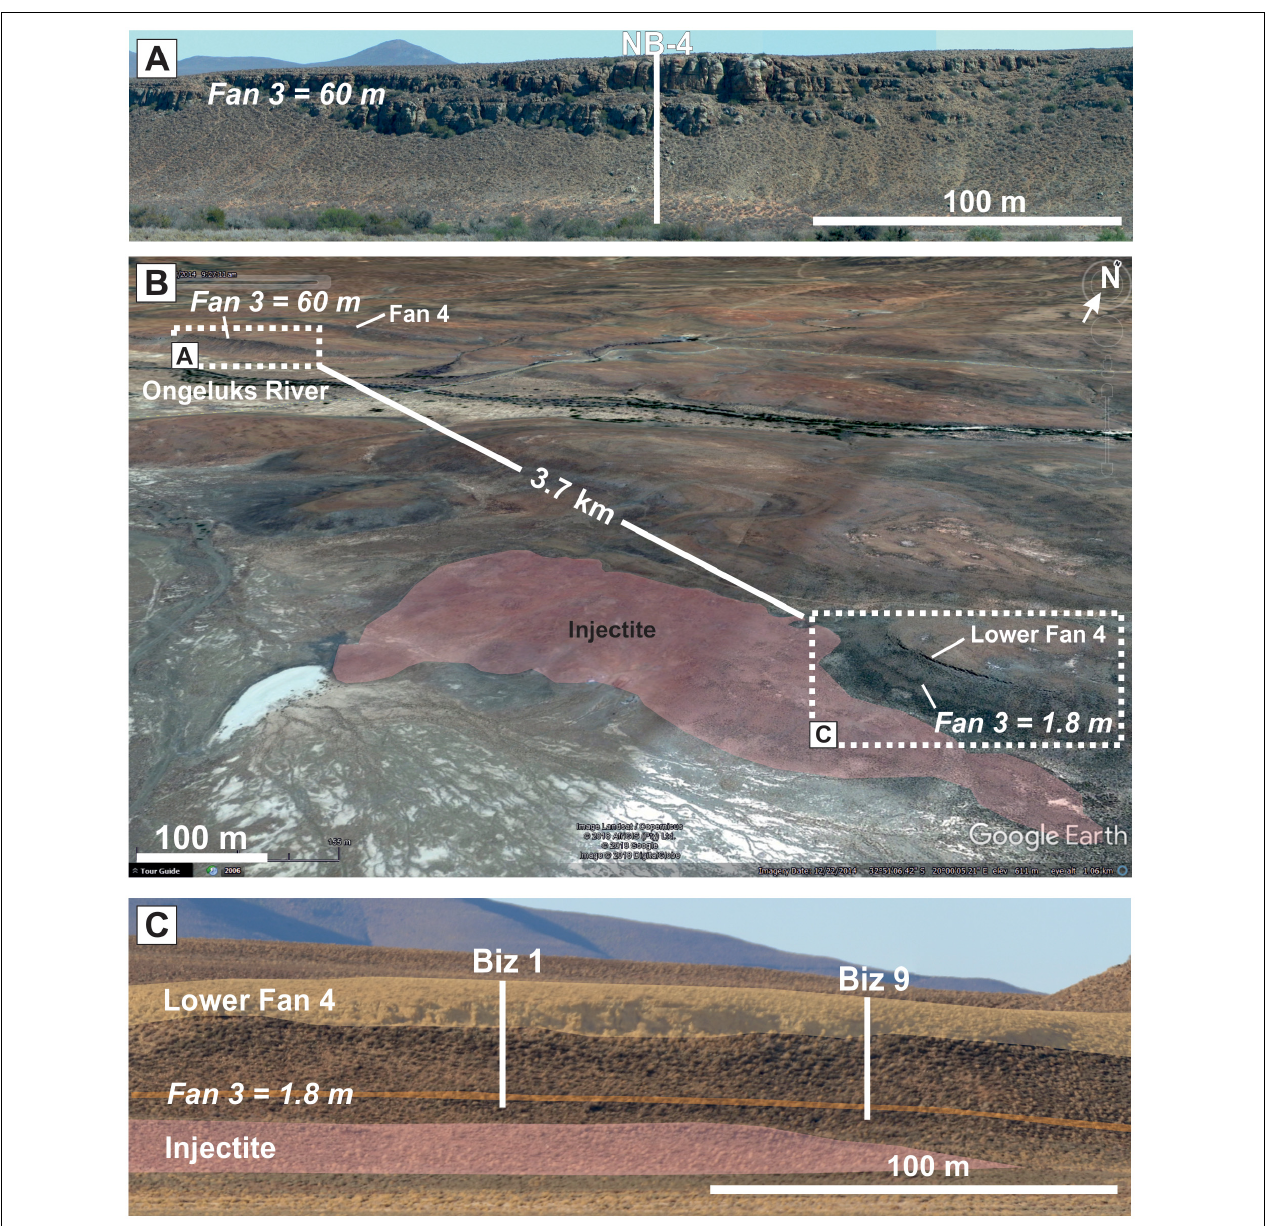
FIGURE 9 | Photos and Google Earth view of the oblique up-dip pinchout of Fan 3. (A) Photo of the Fan 3 outcrop at Ongeluks River where it is 60 m thick. (B) Google Earth map of the oblique up-dip pinchout area indicating the location of A and C as well as the location of the injectite complex. (C) Photo of Fan 3 and lower Fan 4 showing the rapid thinning of Fan 3 over 3.7 km to the SE of Ongeluks River.